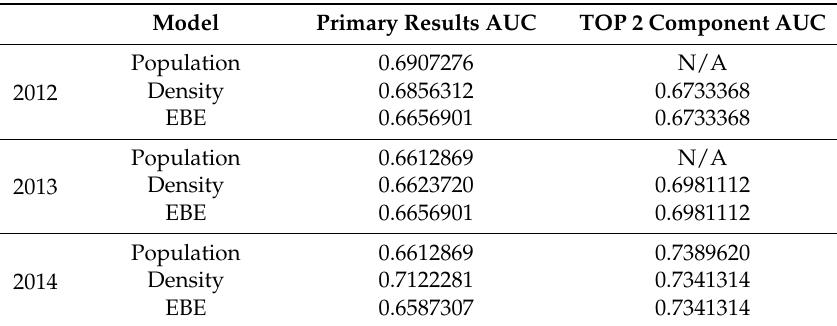
Table 3. ROC AUC result. There was no difference between the inputs in the population and population density models for 2012–2013 when only the top two component variables were